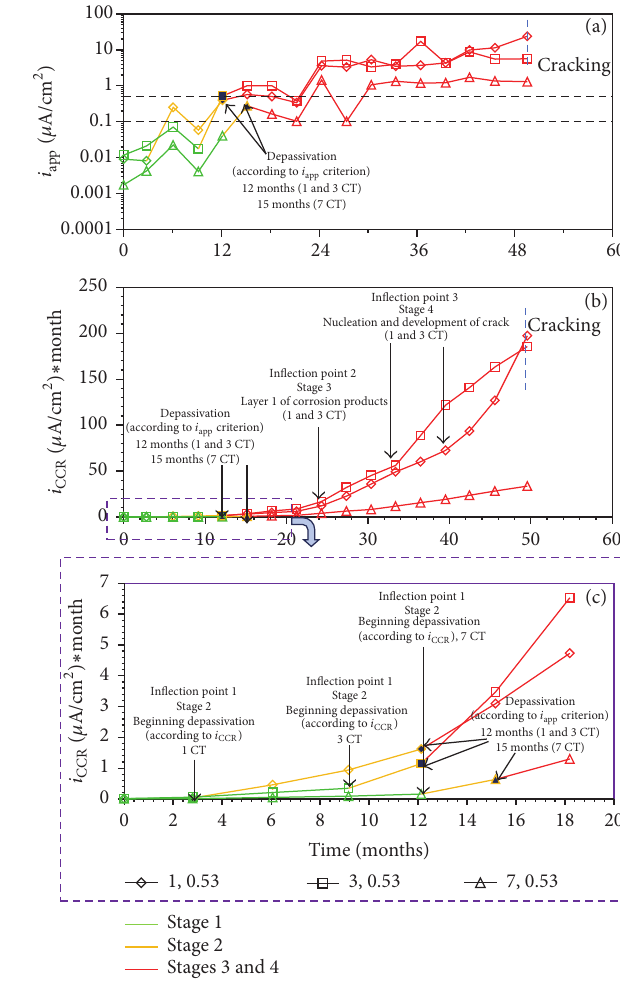
Figure 3: (a) Average 𝑖 app and (b and c) 𝑖 CCR versus exposure time, w/c ratio = 0.70, and three CTs. Figure 4: (a) Average